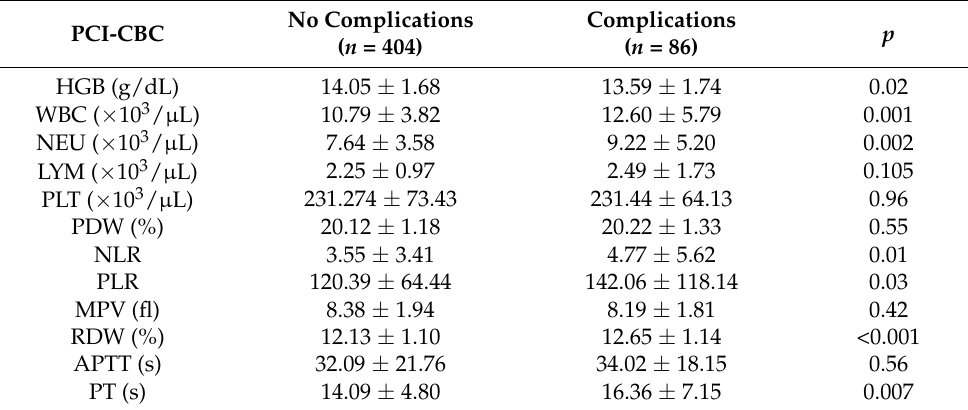
Table 7. Hematological and coagulation parameters of the groups with/without in-hospital compli- cations in ACS patients treated with PCI. No Complications PCI-CBC ( n =